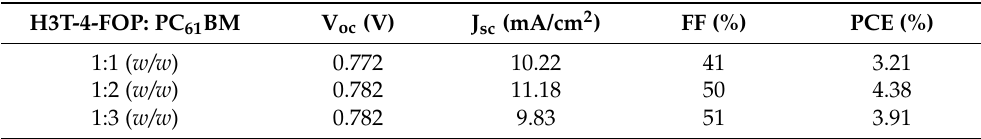
Table 3. Comparative study of fabricated BHJ-OSCs with different organic chromophores and H3T-4-FOP. Organic